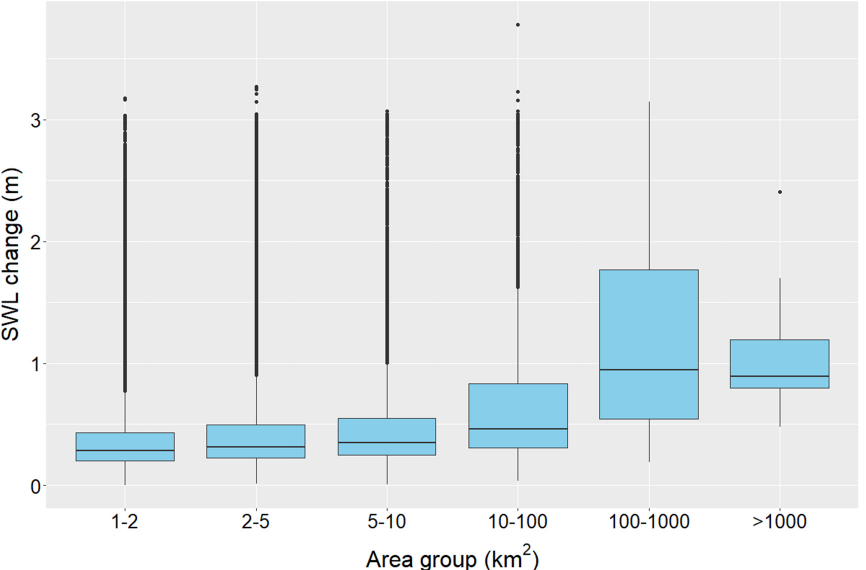
Figure 6. Boxplot of seasonal water level amplitudes for lakes of different sizes. The horizontal line in the box represents the median SWL variation over the three years. The upper and lower limits of the box represent the range of SWL variation. Scatters are outliers for each box, and the number of outliers accounts for 20%, 20%, 17%, 24%, 23%, and l4%, respectively (the total number of lakes in each group is shown in Table 2).